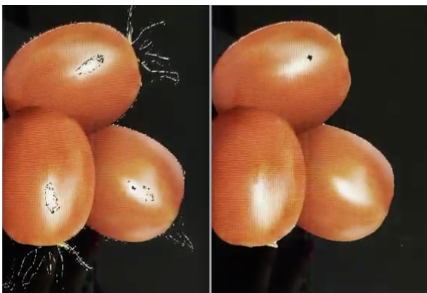
Figure 6. Neural network prediction and its corresponding post-processing